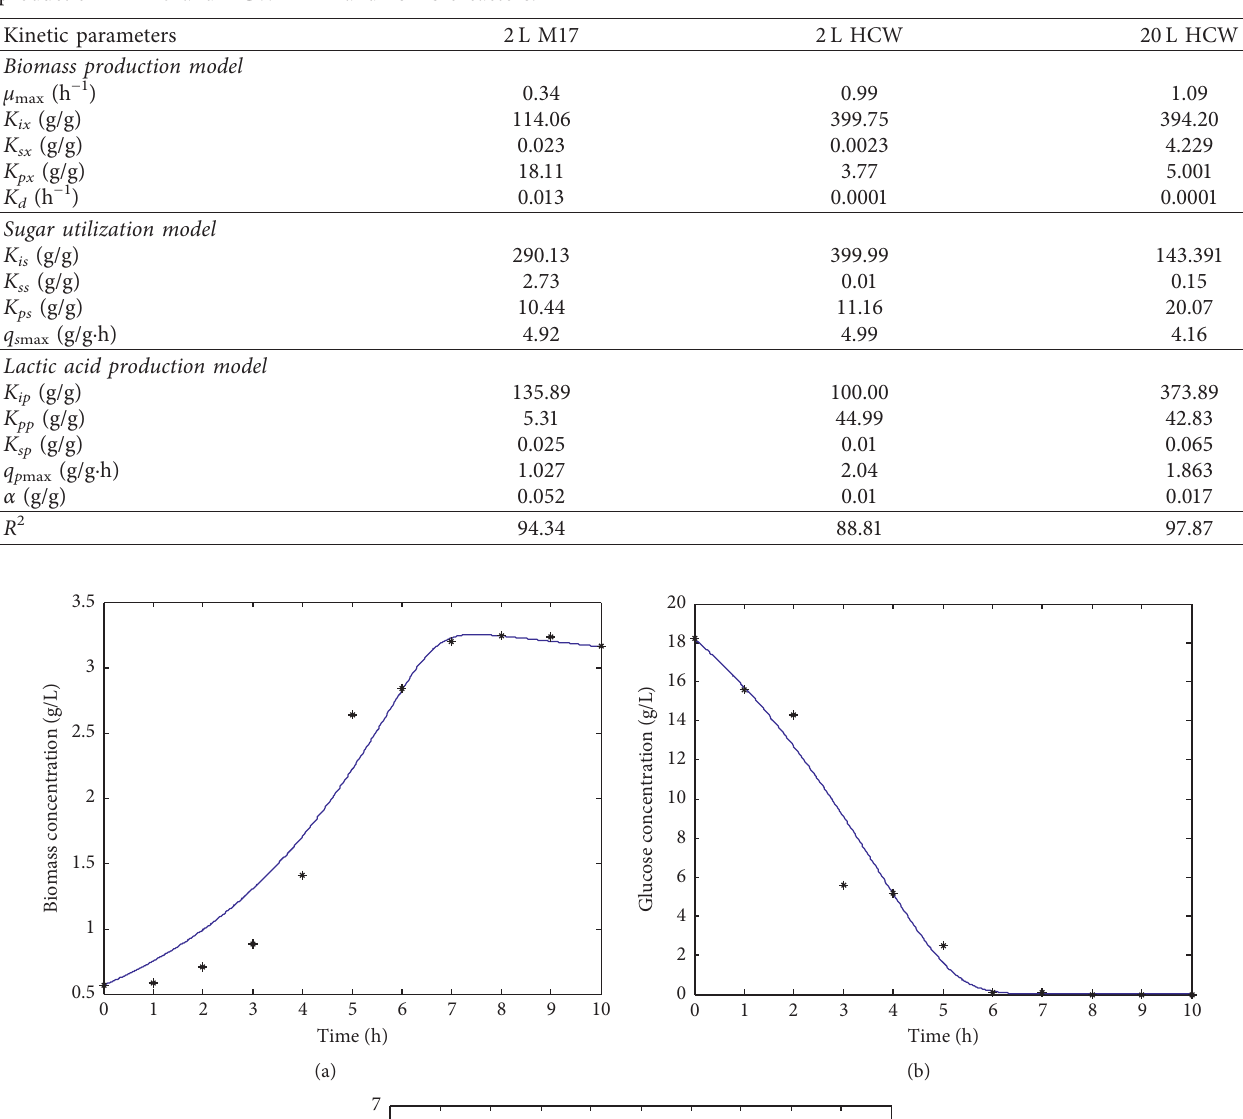
Table 2: Best-fitting values of kinetic parameters obtained by modeling Enterococcus faecalis SLT13 growth, sugar utilization, and lactic acid production in M17 and HCW in 2 L and 20L